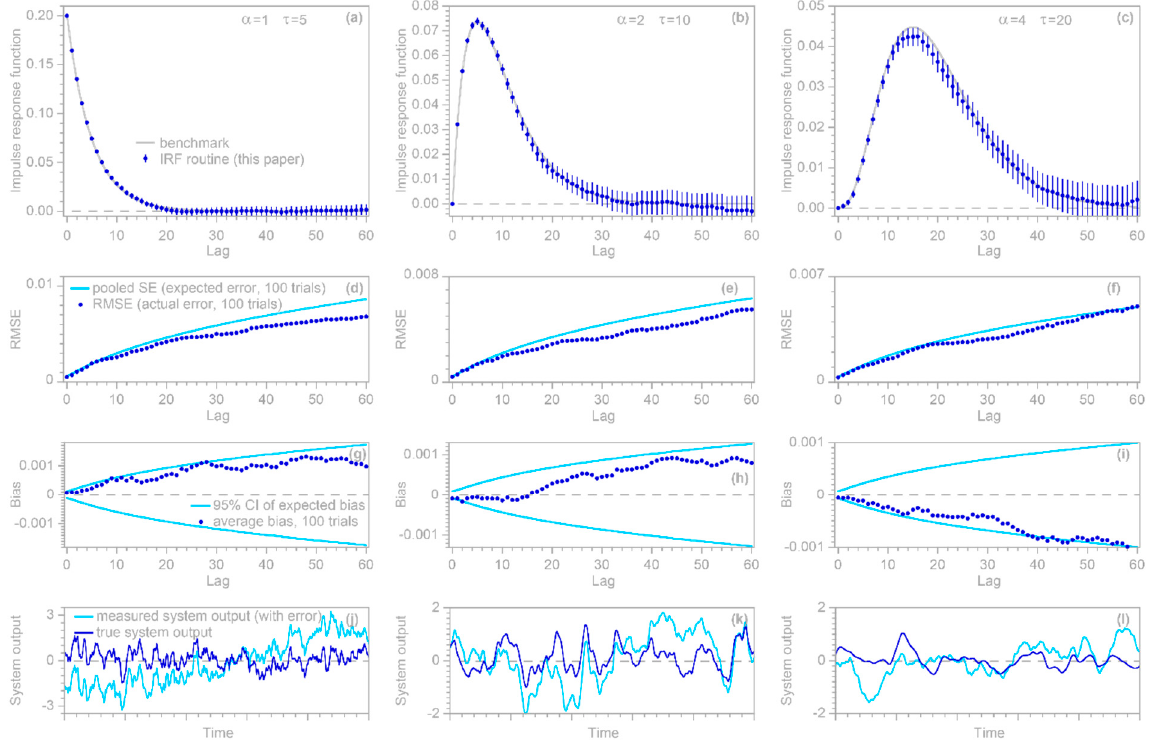
Figure 3. Benchmark tests of impulse response function (IRF) calculations with nonstationary ARIMA noise. Top row ( a – c ): IRFs calculated from noisy time series (dark symbols), compared to the true convolution kernels (gray lines) used as benchmarks; error bars indicate one standard error. Benchmarks are gamma distributions with shape factors of 1, 2, and 4 in the left, center, and right columns, respectively. Second row ( d – f ): test of standard error estimates, obtained by repeating the analysis in the top row for 100 different randomizations. The estimates of expected deviations from the benchmark (the pooled standard errors at each lag, shown by light blue lines) roughly agree with the actual deviations from the benchmark (root mean square average of deviations from the benchmark at each lag, shown by dark blue symbols). Third row ( g – i ): dark blue points show the average deviation from the benchmark in 100 different randomizations of the analysis in the top row, and the light blue lines show the 95% confidence interval of average deviations from the bench ‐ mark. The dark points generally lie between the blue lines, indicating that the IRFs are unbiased. Bottom row ( j – l ): true convolution output 𝑦 (cid:3037) (dark blue lines) compared to the ARIMA noise ‐ cor ‐ rupted 𝑦 (cid:3037) used as input to IRF calculations (light blue lines). Five hundred time steps, equaling five percent of each time series, are shown. Because the noise is nonstationary, the noise ‐ corrupted time series (light blue lines) eventually wander far away from the true 𝑦 (cid:3037) (dark blue lines). The bottom panels show time intervals where they nearly overlap, so that they can be visualized together. 3. Using Demixing Techniques to Quantify System Response to Heterogeneous Inputs 3.1. Demixing Multiple Impulse Response Functions